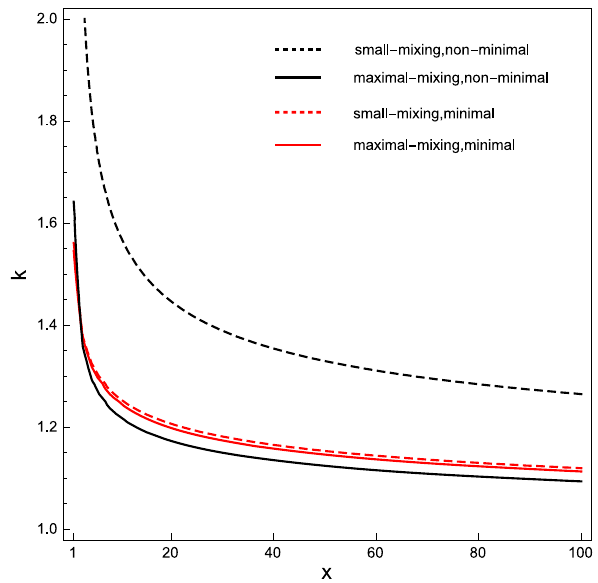
(cid:15) ( 125 GeV ) 2 − M 2 Z